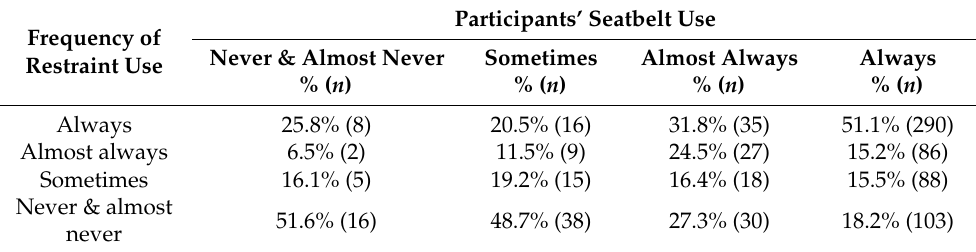
Table 6. Participants’ seatbelt use and frequency of restraint use for their eldest child while travelling in a vehicle.